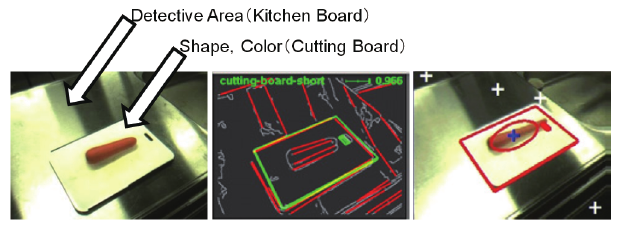
Figure 3. A cutting board and vegetable recognition based on the shape